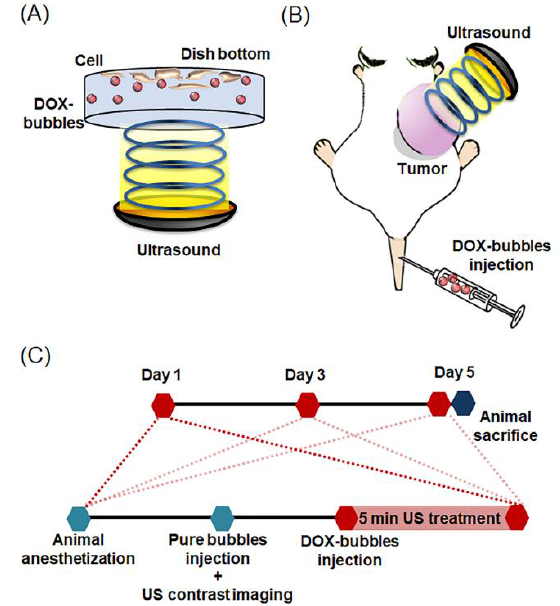
Figure 2. Experimental setup of ( A ) cell experiment and ( B ) animal tumor treatment. ( C ) Diagram of the osteosarcoma animal tumor treatment protocol.